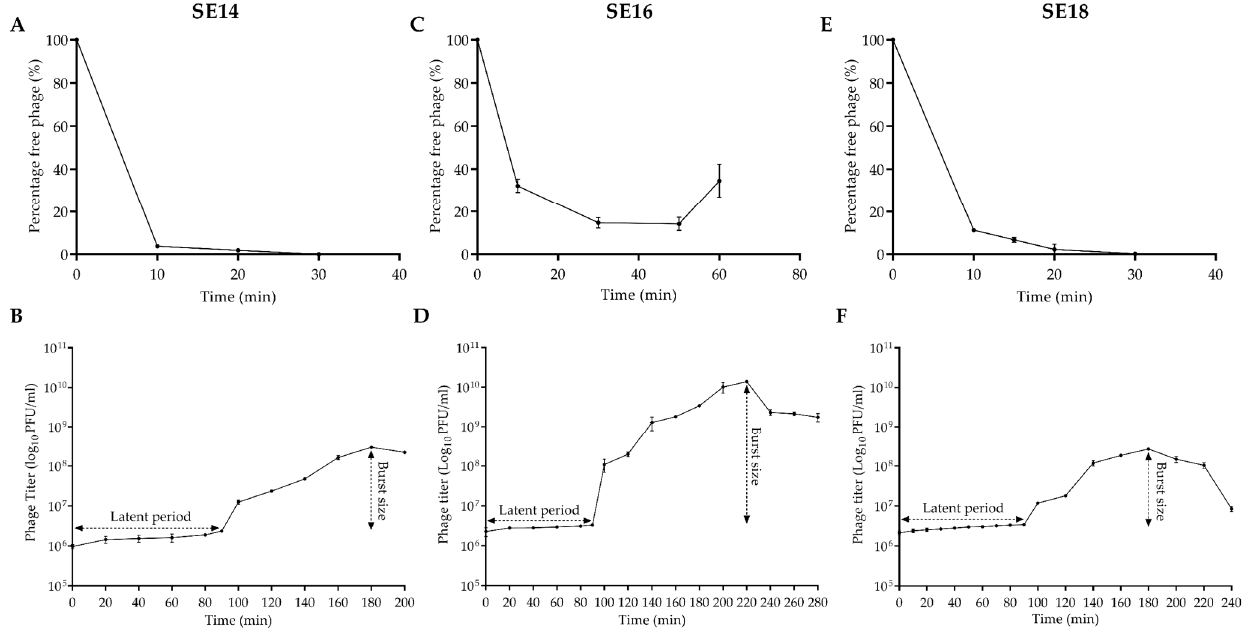
Figure 2. Adsorption ( upper row ) and one-step growth curves ( lower row ) of CUB-EPI_14 assessed on S. epidermidis strains SE14 ( A , B ), SE16 ( C , D ), and SE18 ( E , F ). Data are expressed as mean ± SD.